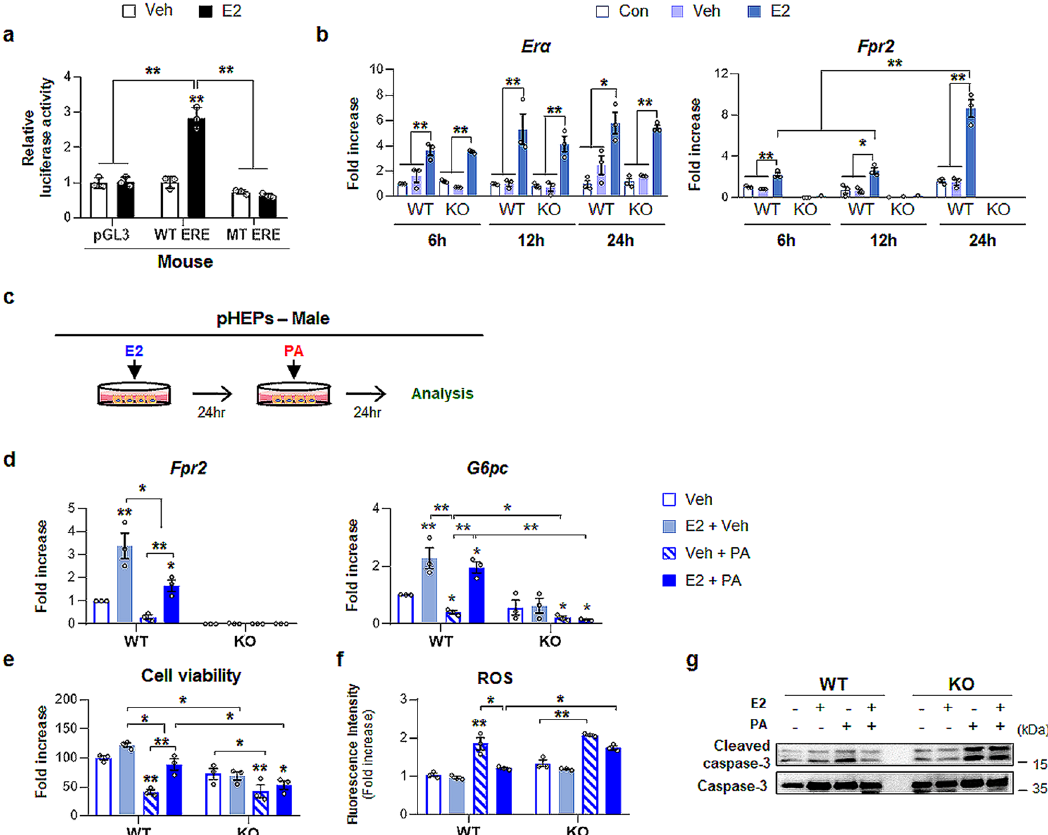
Fig. 8 Estradiol protects hepatocytes from lipotoxicity by upregulating Fpr2. a Dual luciferase reporter assay in AML12 cells transfected with a pGL3 vector having either WT- or mutant (MT-) ERE on the promoter region of Fpr2. These cells were exposed to either 100 nM estradiol (E2) or vehicle (Veh). Mean± S.E.M. results are graphed (* p < 0.05, ** p < 0.005 vs Veh). b qRT-PCR analysis for Estrogen receptor alpha (Er α ) and Fpr2 in primary hepatocytes isolated from WT and KO male mice treated with none (Con), vehicle (veh) or E2. The mean ± S.E.M. results obtained from three repetitive experiments are graphed (* p < 0.05, ** p < 0.005 vs Con). c A scheme for cell experiment in which pHEPs treated with either vehicle or 100 nM of E2 were exposed to 250 μ M of PA for 24 h. d qRT-PCR analysis for Fpr2 and G6pc , e cell viability, f intracellular reactive oxygen species (ROS) levels in these cells. and g western blot analysis for cleaved Caspase-3 and pro-Caspase-3 The mean ± S.E.M. results obtained from three repetitive experiments are graphed (* p < 0.05, ** p < 0.005 vs WT-Veh). The data shown represent one of three experiments with similar results. Gray circles represent individual data points. See Supplementary Data for statistical